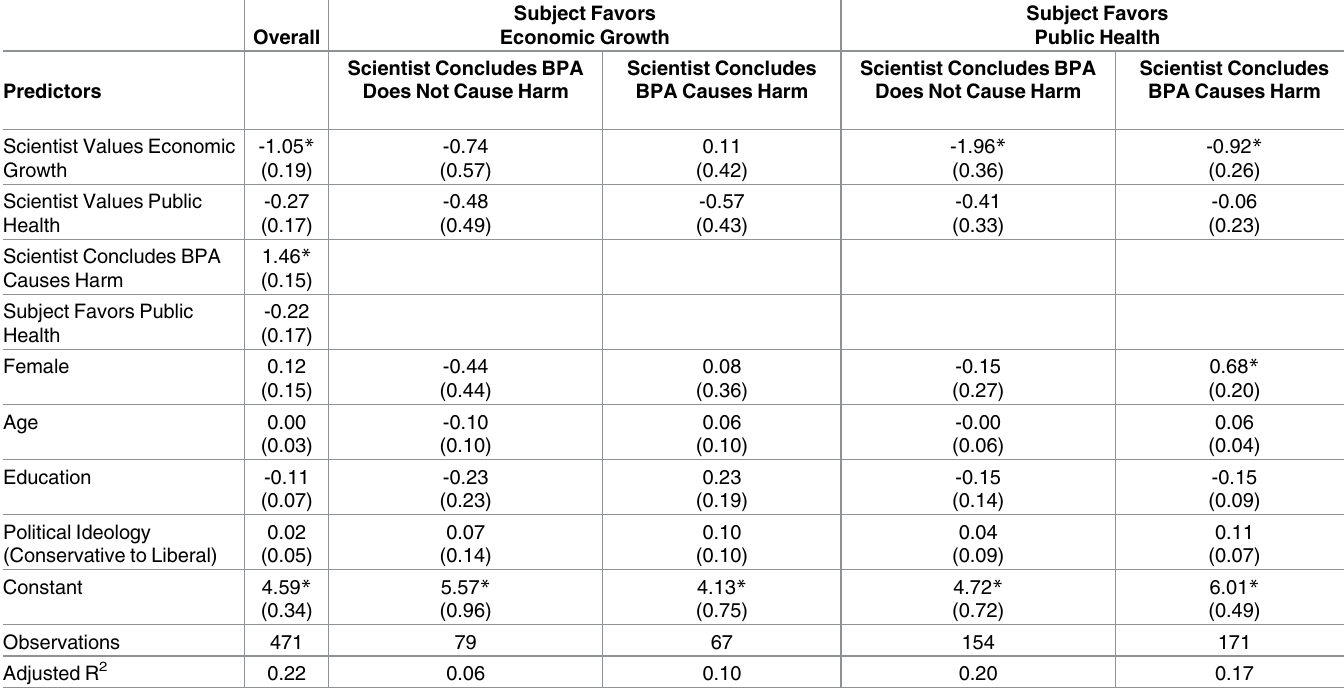
Table 4. Measuresof the effect of scientists’ policy recommendations and expressedvalues on respondents’ trust (Experiment 2).